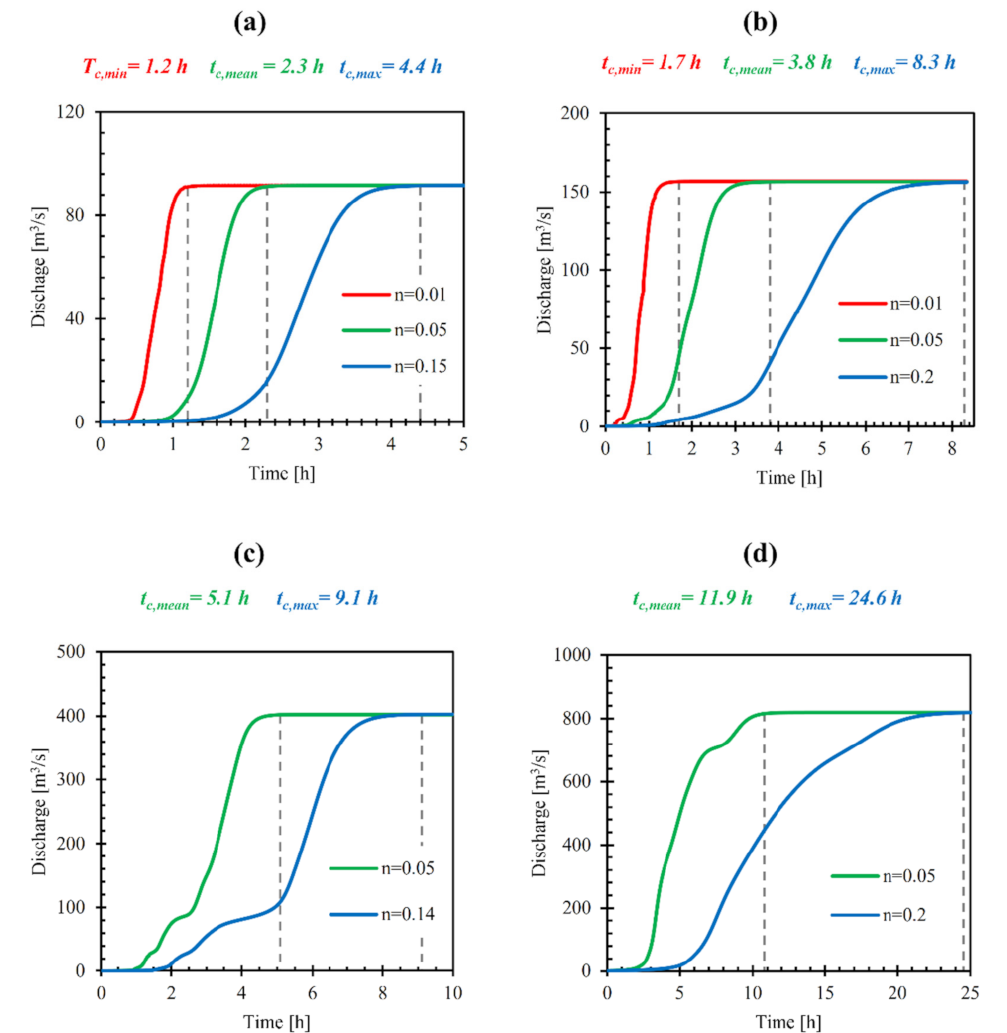
Figure 2. Calculated S-type hydrographs related to the minimum (red line), maximum (blue line), and mean (green line) time of concentration ( t c ) calculated with empirical formulas, and each corresponding Manning coefficient ( n ): ( a ) Brazos basin, Cow Bayu; ( b ) San Antonio basin, Escondido Creek; ( c ) Trinity basin, North Creek; and ( d ) Brazos basin, North Elm